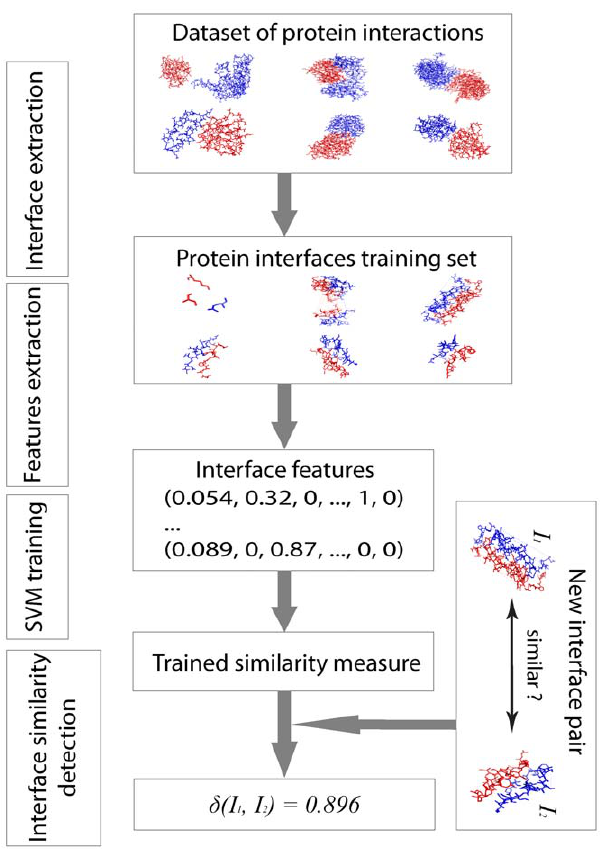
Figure 2. An overview of machine learning approach to determine interface similarity measure. First, interface structures are extracted from the training sets of similar and dissimilar interaction interfaces. Second, for each pair of interfaces a 106-dimensional feature vector is calculated. Third, a Support Vector Machines classifier is trained and evaluated using the above datasets. Last, a protein interface similarity measure d (I 1 , I 2 ) is defined for two interfaces, I 1 and I 2 , as the distance between the corresponding106-dimensional feature vector and the separating hyperplane.